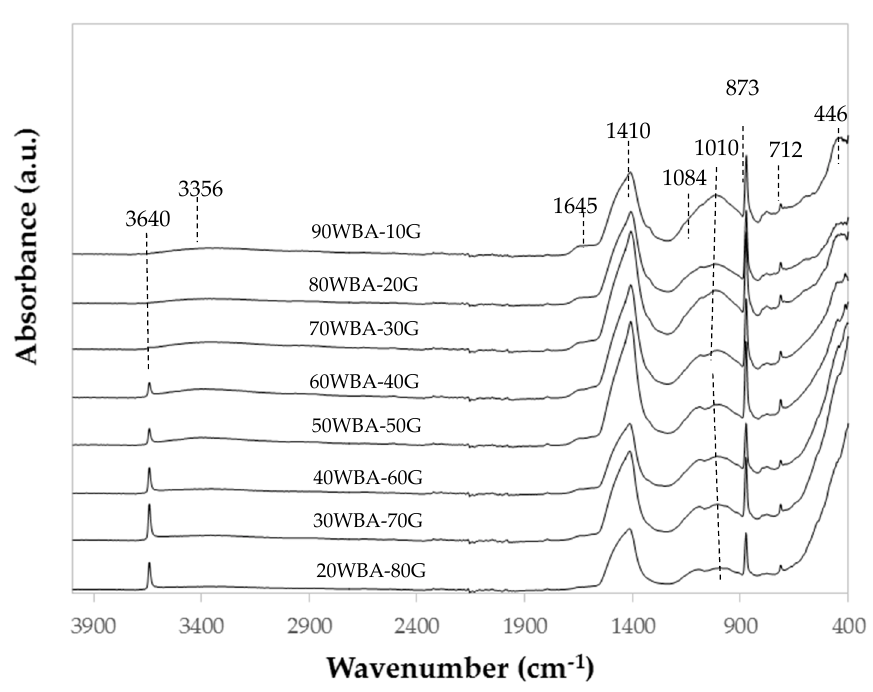
Figure 7. FTIR spectra of calcium silicate